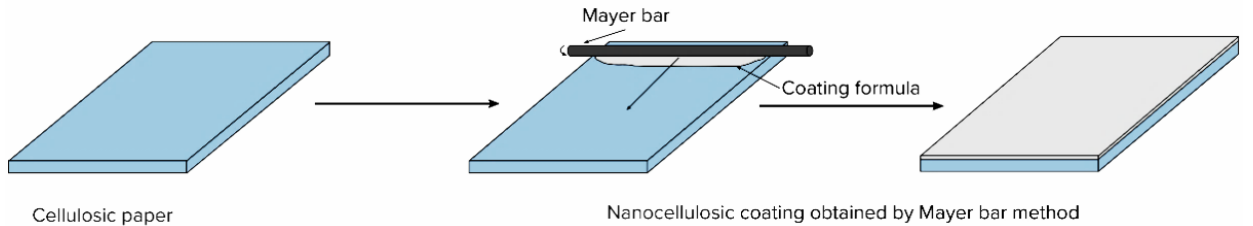
Figure 1. Scheme of coating application on a cellulose substrate with a Mayer bar.